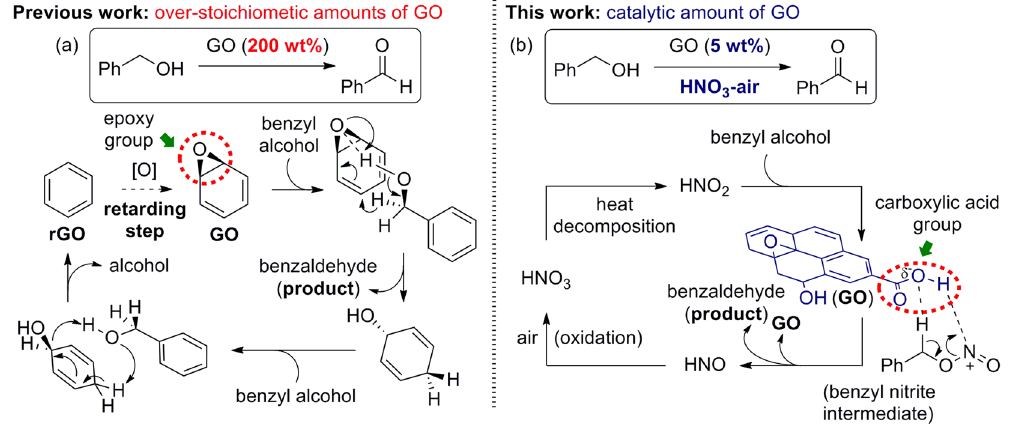
Figure 1. ( a ) Scarified epoxy functional group serving as a reagent. ( b ) The vital role of the carboxylic acid group in GO moieties as a catalyst for the oxidation of alcohols to aldehydes.